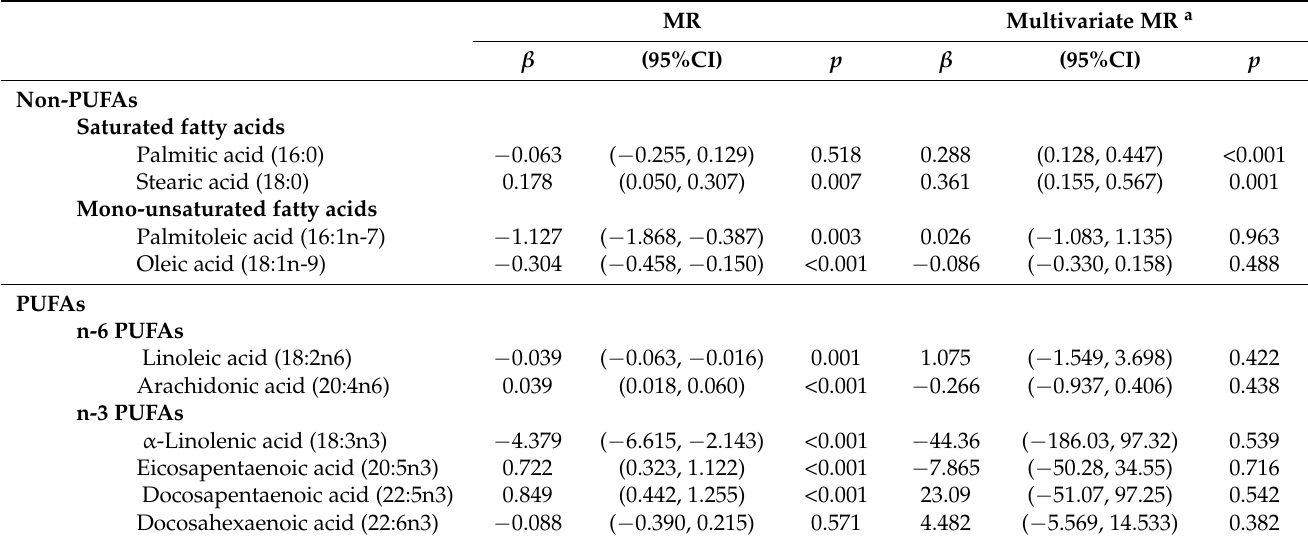
Table 3. MR results of the fatty acids and frailty index.